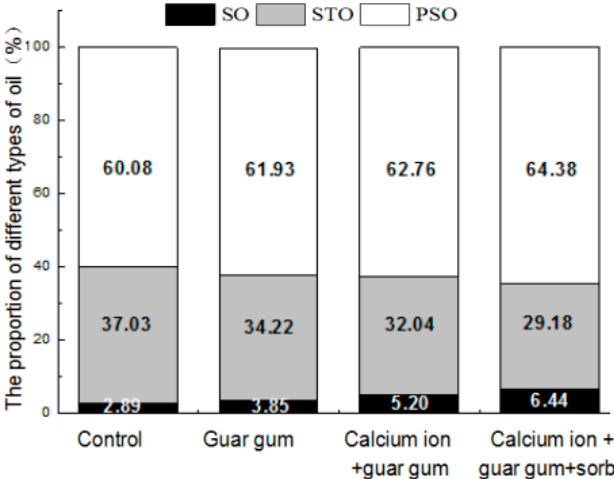
Figure 1. Effect of coating treatments on total oil content and oil fractions of the French fries. Data values are means ± SD ( n = 3, N = 12). The same letter in column means no significantly different ( p > 0.05).